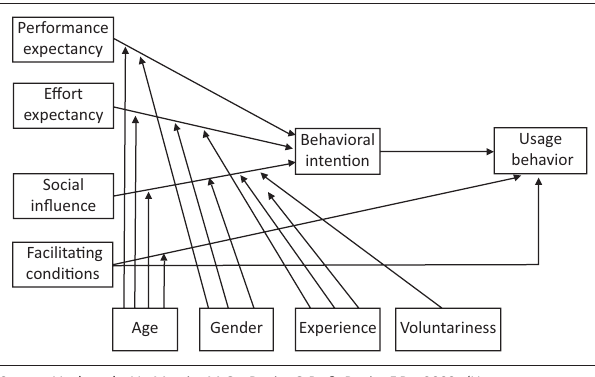
FIGURE 2: Technology Acceptance Model 2.